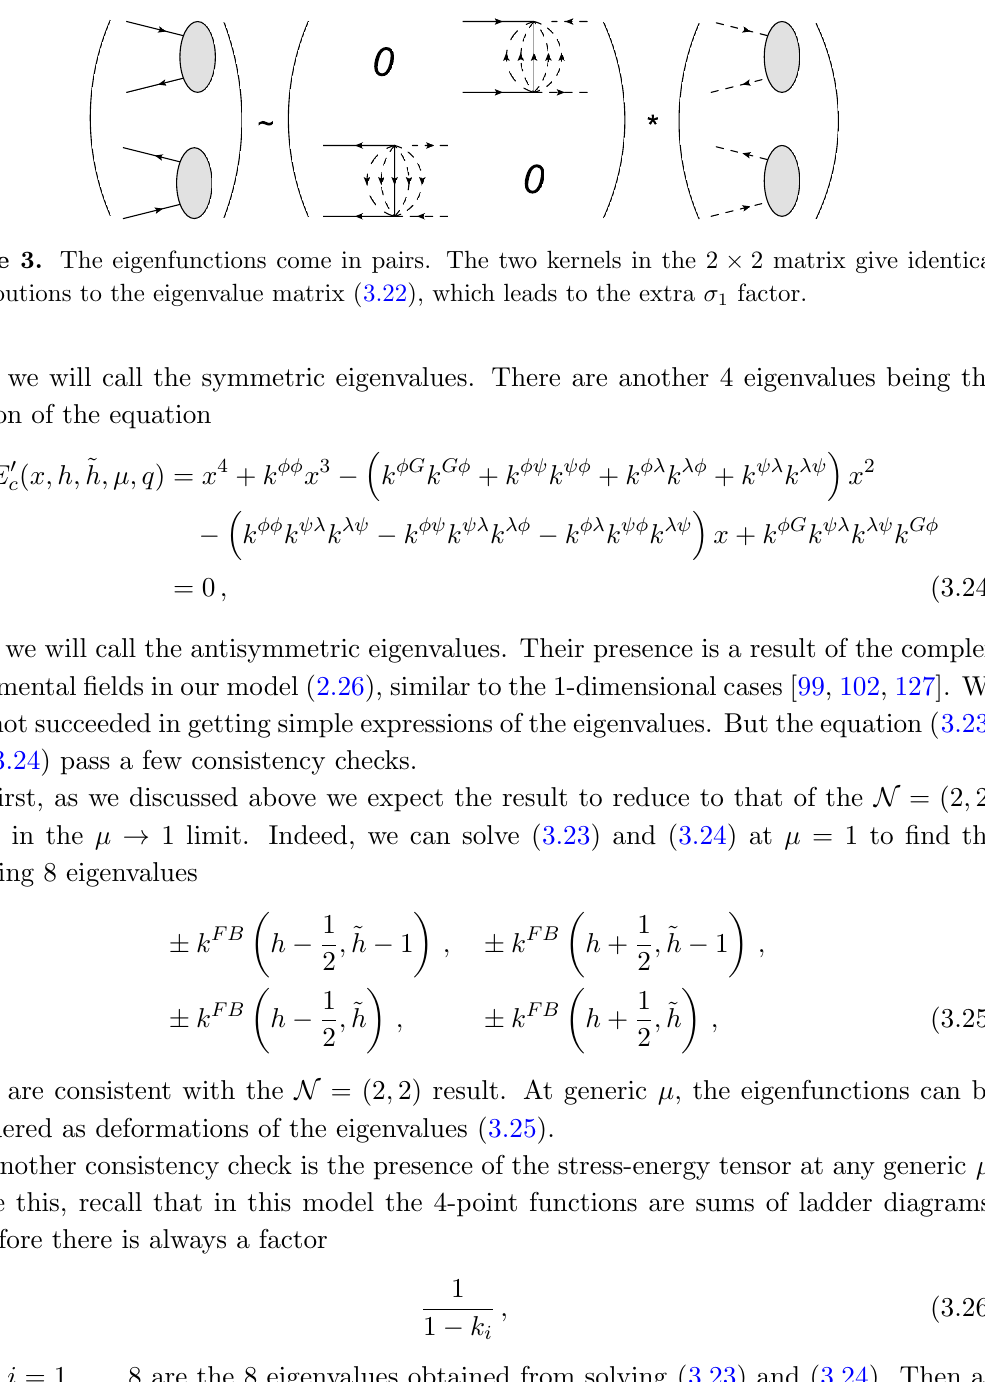
Figure 2. Action of a single kernel.